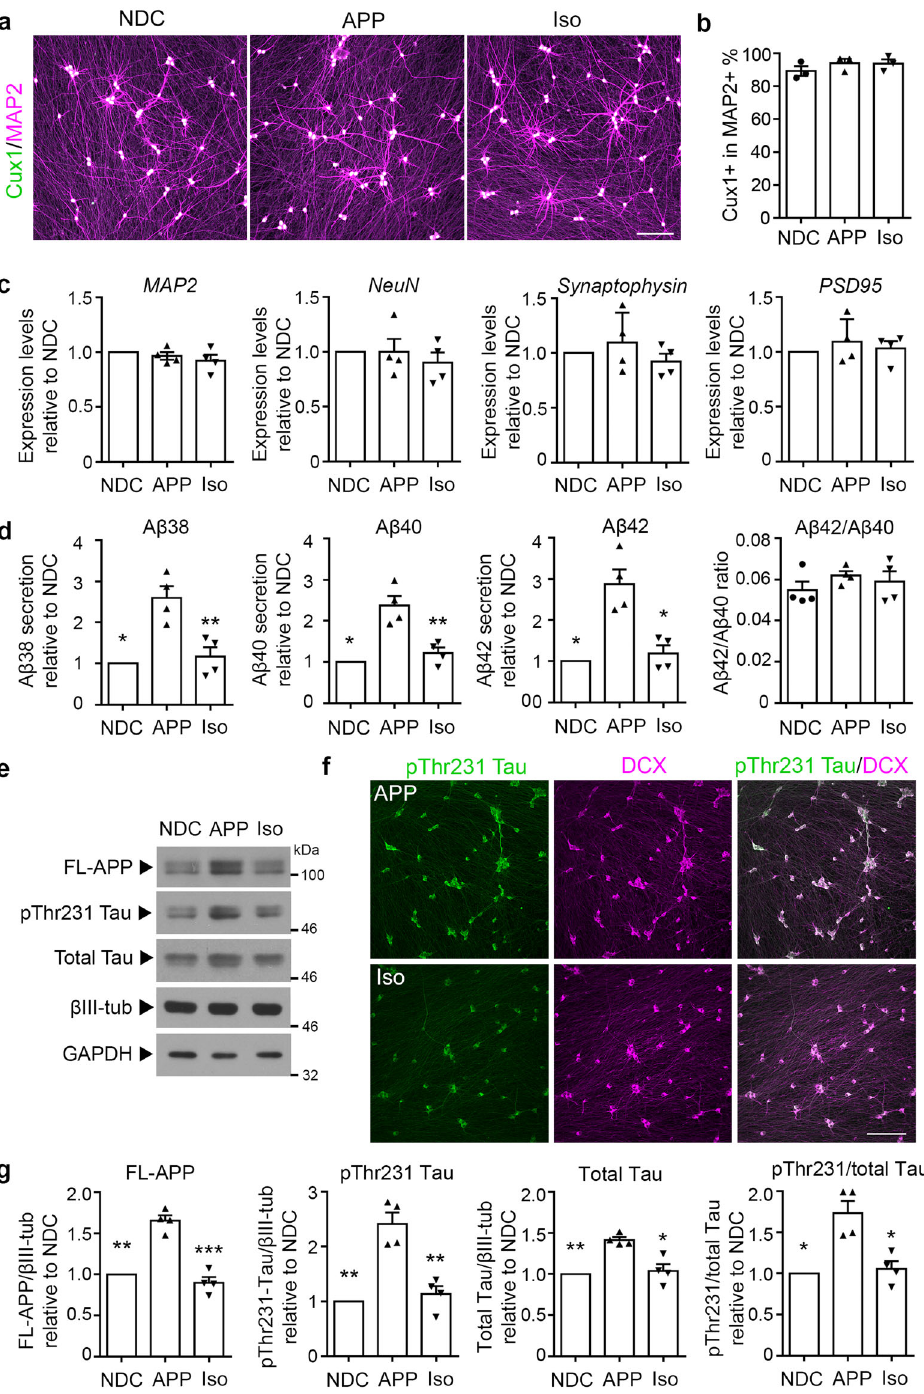
Fig. 2 CRISPR/Cas9-mediated correction of APP copy number alleviates amyloid- and Tau-associated pathologies in induced pluripotent stem cell- derived neurons. a , b Generation of a homogenous population of cortical neurons from nondemented control (NDC), APP duplication parent (APP), and APP copy number-corrected isogenic (Iso) cell lines. a Neurons at 28 days in vitro (DIV) were stained for MAP2 (neuronal marker) and Cux1 (cortical layer II – IV marker). b Percentages of Cux1- and MAP2-positive neurons. c Neuronal differentiation status as assessed by qRT-PCR for MAP2 , NeuN (mature neuron marker), Synaptophysin (presynaptic marker), and PSD-95 (postsynaptic marker). d Levels of secreted amyloid-beta (A β ) 38 , A β 40 , and A β 42 as well as A β 42 /A β 40 ratios in conditioned media from NDC, APP, and Iso neurons at 28 DIV. e Western blot analysis of full-length APP (FL-APP), phosphorylated Tau at Thr231 (pThr231 Tau), and total Tau in NDC, APP, and Iso neurons at 28 DIV. β III-tubulin ( β III-tub) and GAPDH served as loading controls for neurons and total protein, respectively. f Immunocytochemical analysis of pThr231 Tau and doublecortin (DCX) in APP and Iso neurons at 28 DIV. g Quanti fi cation of APP/ β III-tub, pThr231 Tau/ β III-tub, total Tau/ β III-tub, and pThr231/total Tau ratios relative to those in NDC neurons. Values are mean ± SEM ( n = 4 independent biological replicates per cell line; * p < 0.05, ** p < 0.01, or *** p < 0.001 vs. APP neurons, Student ’ s t -test). Scale bars: 100 μ